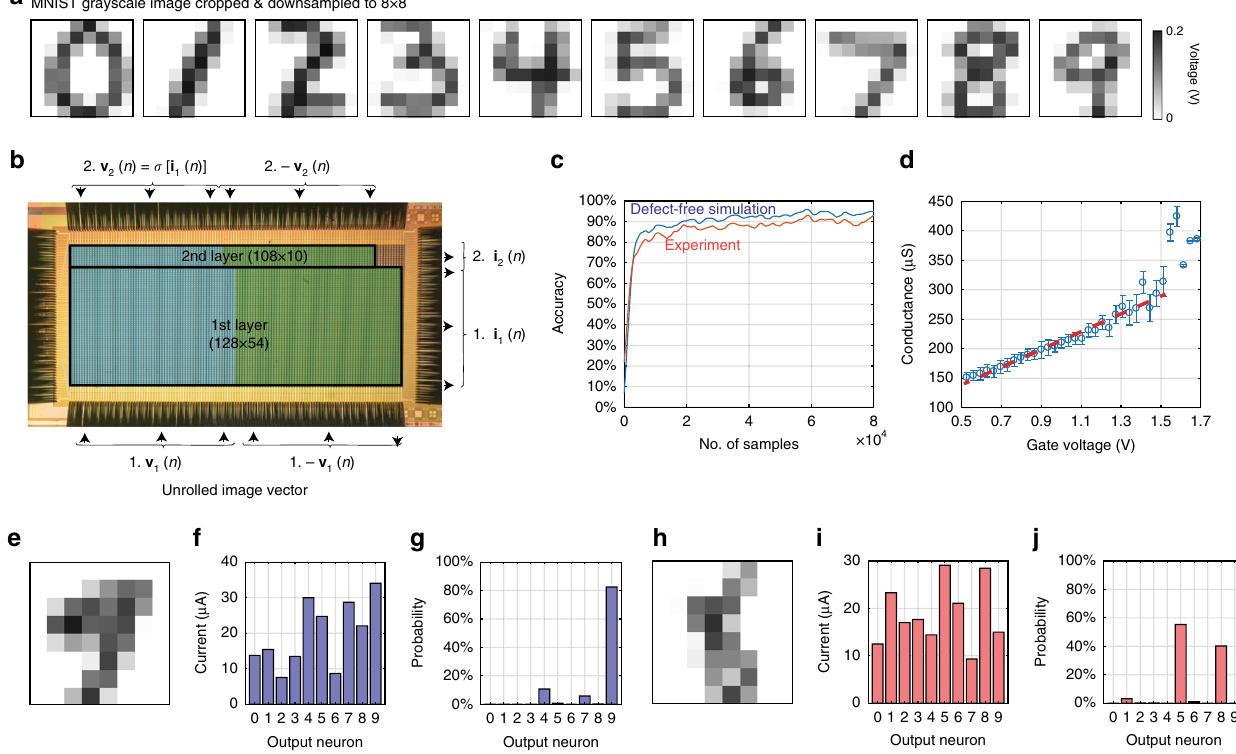
Fig. 3 In situ online training and inference experiments on Modi fi ed National Institute of Standards and Technology (MNIST) handwritten digit recognition. a Typical handwritten digits from the MNIST database. b Photo of the integrated 128 × 64 array during measurement. The array was partitioned into two parts for the fi rst and second layers, respectively. In all, 54 hidden neurons were used, so the fi rst layer weight matrix is 64 × 54 (implemented using 6912 memristors) and the second layer matrix is 54 × 10 (implemented using 1080 memristors). The blue and green false-colored areas are the positive and negative parts of the differential pairs. c Minibatch accuracy increases over the course of training. Experimental data followed the defect-free simulation closely, with a consistent 2 – 4% gap. d The conductance-gate voltage relation extracted from data collected during training. The conductance was read using the scheme described in the Methods. The conductance includes the effects of sneak-paths and wire resistance, which makes the measured values smaller and the variance larger than those in Fig. 1b, c. The dashed line indicates the mean conductance, while the error bars show a 95% con fi